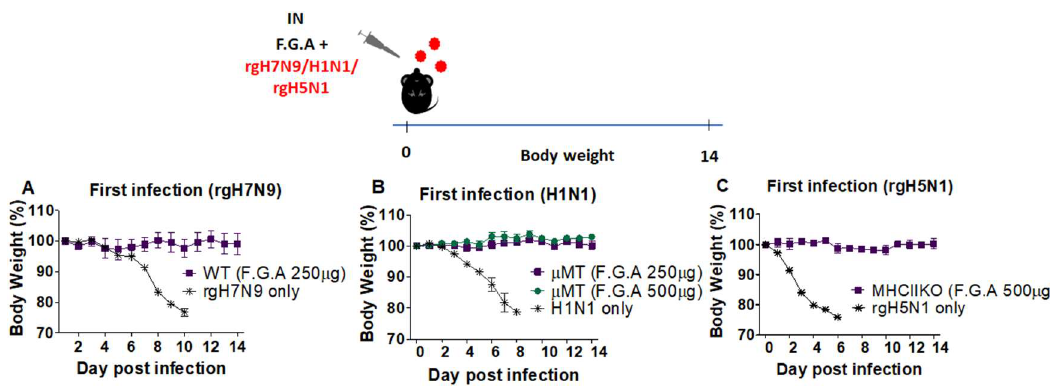
Figure 4. Fermented ginseng sample A had antiviral protective effects against H1N1 or rgH5N1 influenza virus even in severe immune-deficient mice. Groups of wild-type ( n = 3, C57BL/6) and mutant mice ( n = 3, B cell-deficient and MHCIIKO) were intranasally (IN) infected with a mixture of virus (2 LD 50 ) and fermented ginseng sample A at different doses (250 and 500 µ g). Body weight changes were monitored for 14 days after the infection. ( A ) A/Shanghai/2013 (rgH7N9, 2 LD 50 ) virus inoculation in wild-type mice; ( B ) A/California/2009 (H1N1) virus inoculation in µ MT (B cell deficient) mice; ( C ) A/Vietnam/1203/2004 (rgH5N1) virus inoculation in MHCIIKO mice. F.G.A: fermented ginseng sample A; rgH7N9 only: virus infection without ginseng samples; H1N1 only: virus infection without ginseng samples; rgH5N1 only: virus infection without ginseng samples.